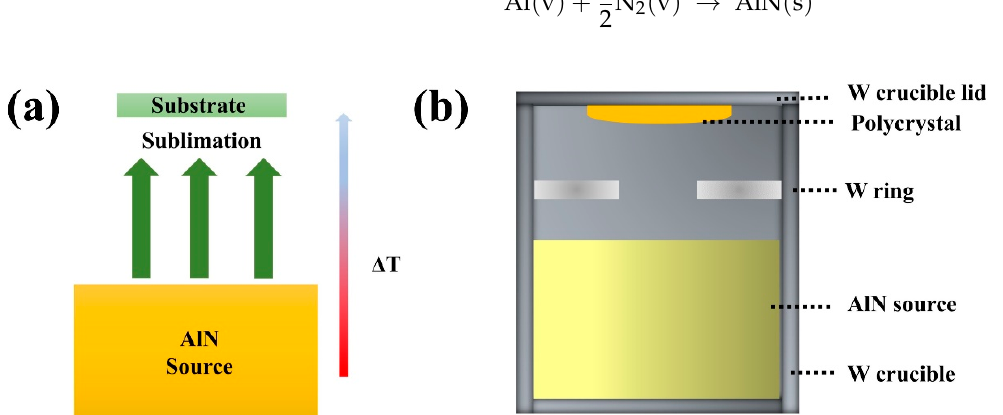
Figure 1. The illustration of the PVT method ( a ) and schematic diagram of the preparation process of AlN seeds ( b ).